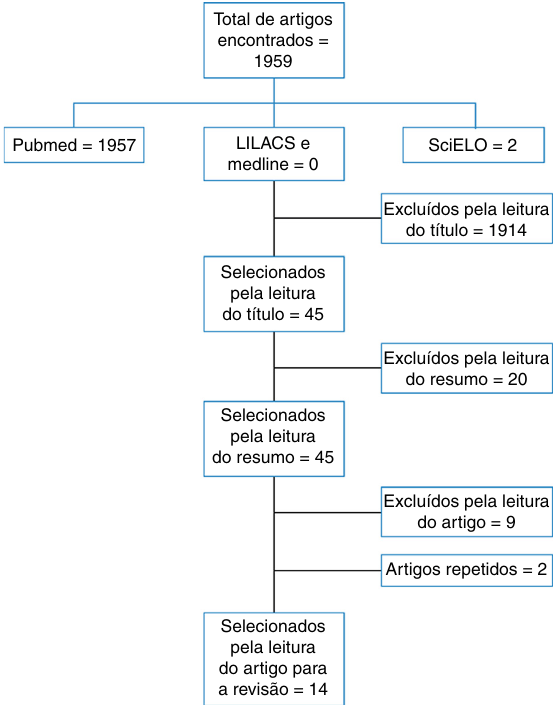
Figure 1 Flowchart of articles identified, excluded and included in the integrative